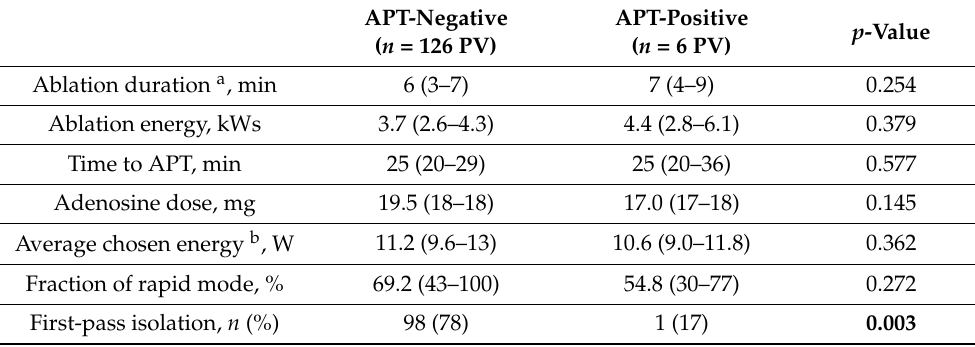
Table 6. Ablation data for